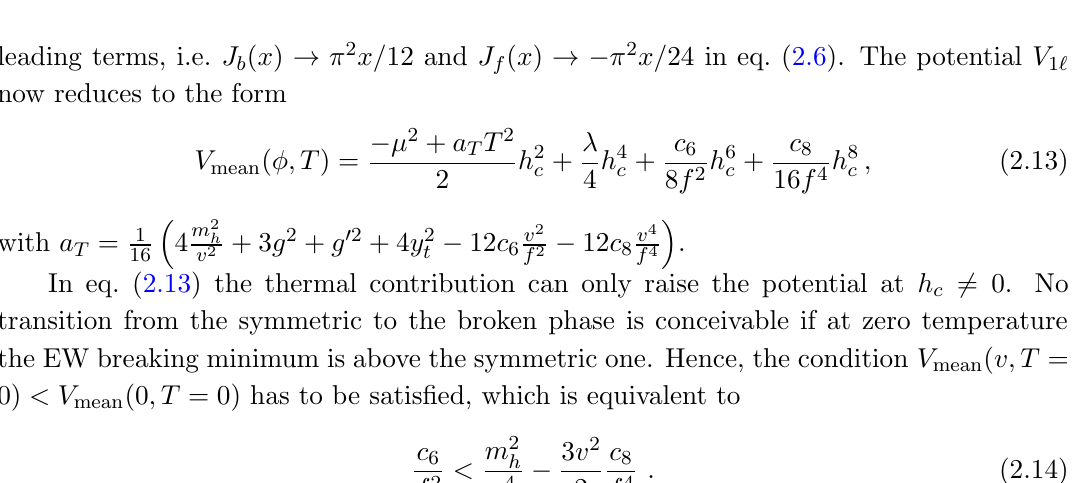
Figure 2 . c 6 =f 2 (cid:0) c 8 =f 4 of parameter space for a SFOEWPT in the mean-(cid:12)eld approximation. Left) The (cid:12)lled region shows the allowed values for c 6 and c 8 such that at T = 0 the deepest minimum is at v . In the darker areas there is a second minimum above the one at v . For negative c 8 , we cut o(cid:11) the potential at 1 TeV and demand that V (1TeV) > V ( v ) to ensure that the global minimum is at v . Superimposed are shades of yellow to green to show the strength of the phase transition, v T =T c , based on the critical temperature. Right) Zoomed version on the black rectangle c of the left panel (note the di(cid:11)erent axis ranges). Lines of constant T c are